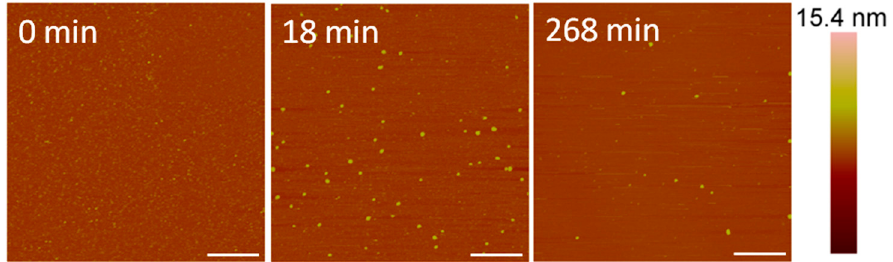
Figure 5 . AFM images of the supported PC membrane after exposure to 10 µM alamethicin. The scale bars represent a distance of 1 µm.